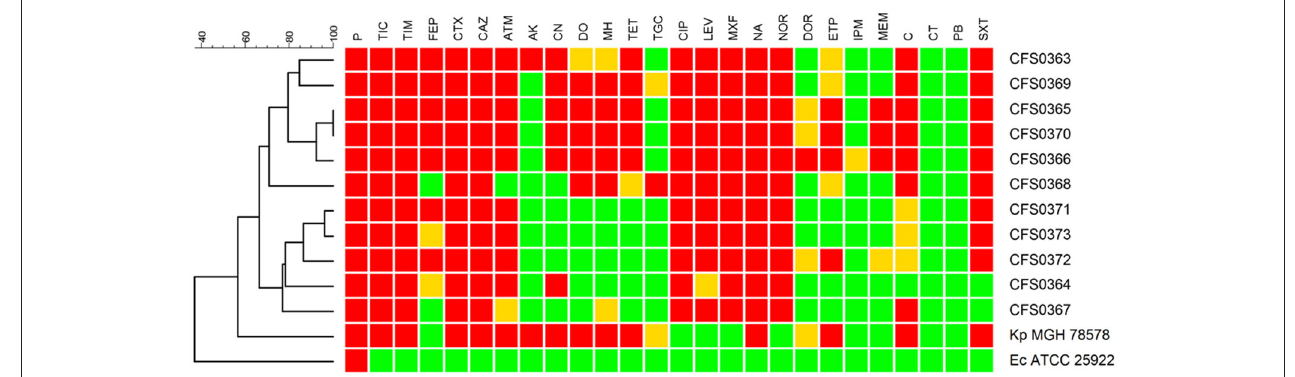
FIGURE 2 | A dendrogram, constructed using the BioNumerics TM software (ver 7.5, Applied Maths), showing the antibiotic resistance profiles obtained following disk diffusion assays. The dendrogram shows two main clusters based on these resistance profiles. Breakpoints were interpreted according to CLSI guidelines 2013